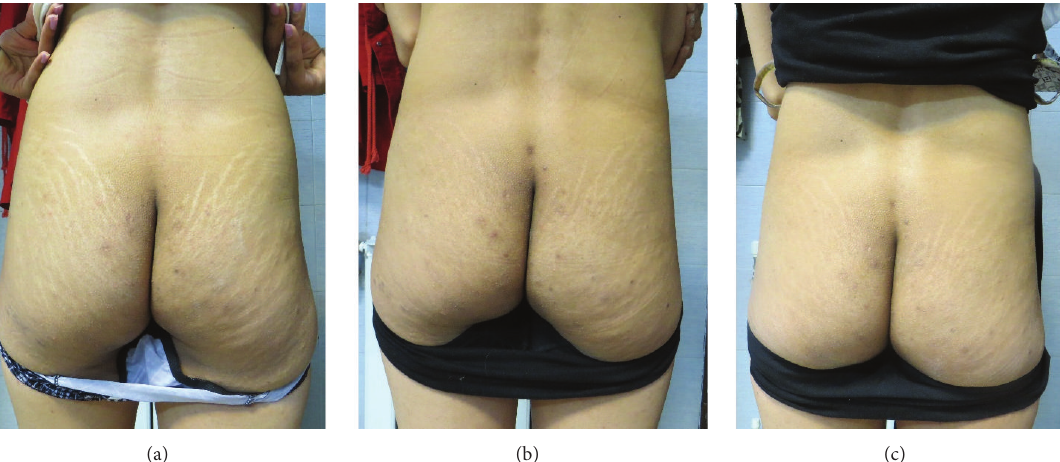
Figure 4: Striae distensae on the buttock of a 30-year-old patient. Significant improvement at 3 months after the end of the study: (a) at baseline; (b) after one month; (c) after three months.